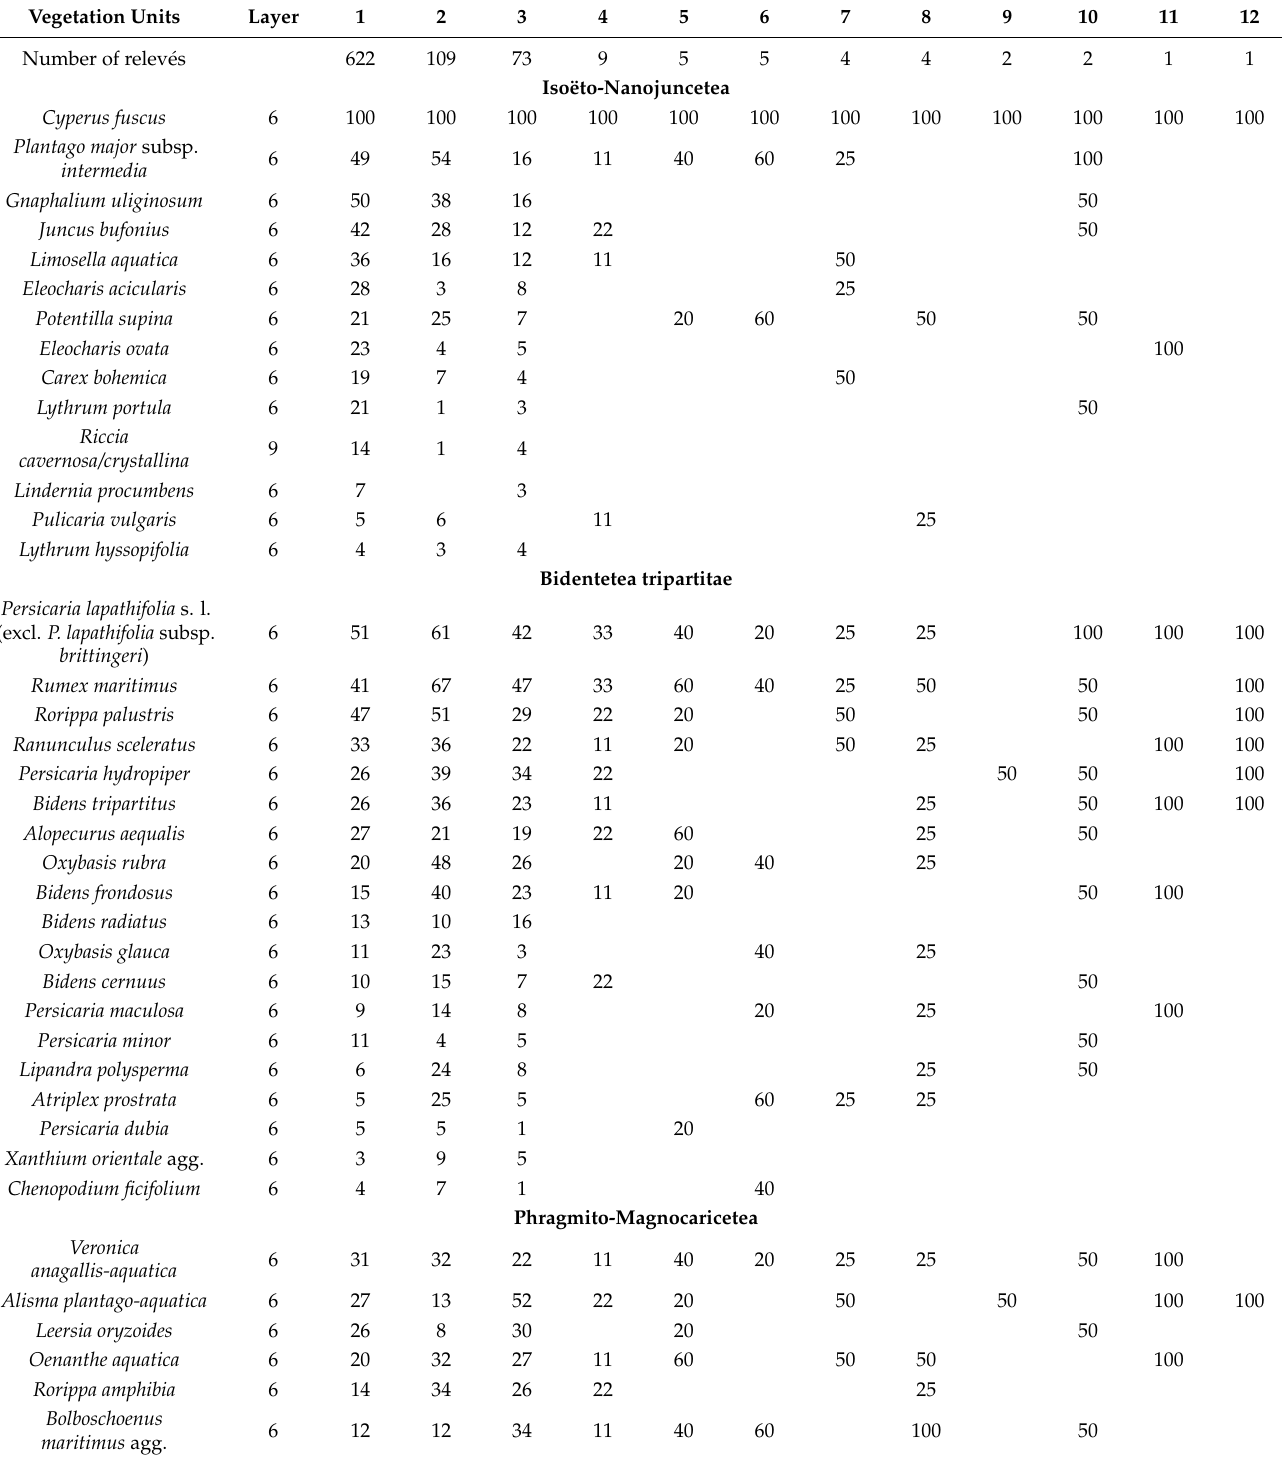
Table 1. Percentage synoptic table of the vegetation with Cyperus fuscus (short version; for full version see Table S5). Classes distinguished: (1) Isoëto-Nanojuncetea; (2) Bidentetea tripartitae; (3) Phragmito-Magnocaricetea; (4) Molinio- Arrhenatheretea; (5) Scheuchzerio-Caricetea nigrae; (6) Crypsietea aculeatae; (7) Potamogetonetea; (8) Festuco-Puccinellietea; (9) Charetea intermediae; (10) Papaveretea rhoeadis; (11) Littorelletea uniflorae; (12) Epilobietea angustifolii. Only the diagnostic species occurring in at least 30 relev é s and the other species occurring in at least 50 relev é s are displayed. Layers: 6—herb layer, 7—juvenile trees and shrubs, 9—bryophyte and algal